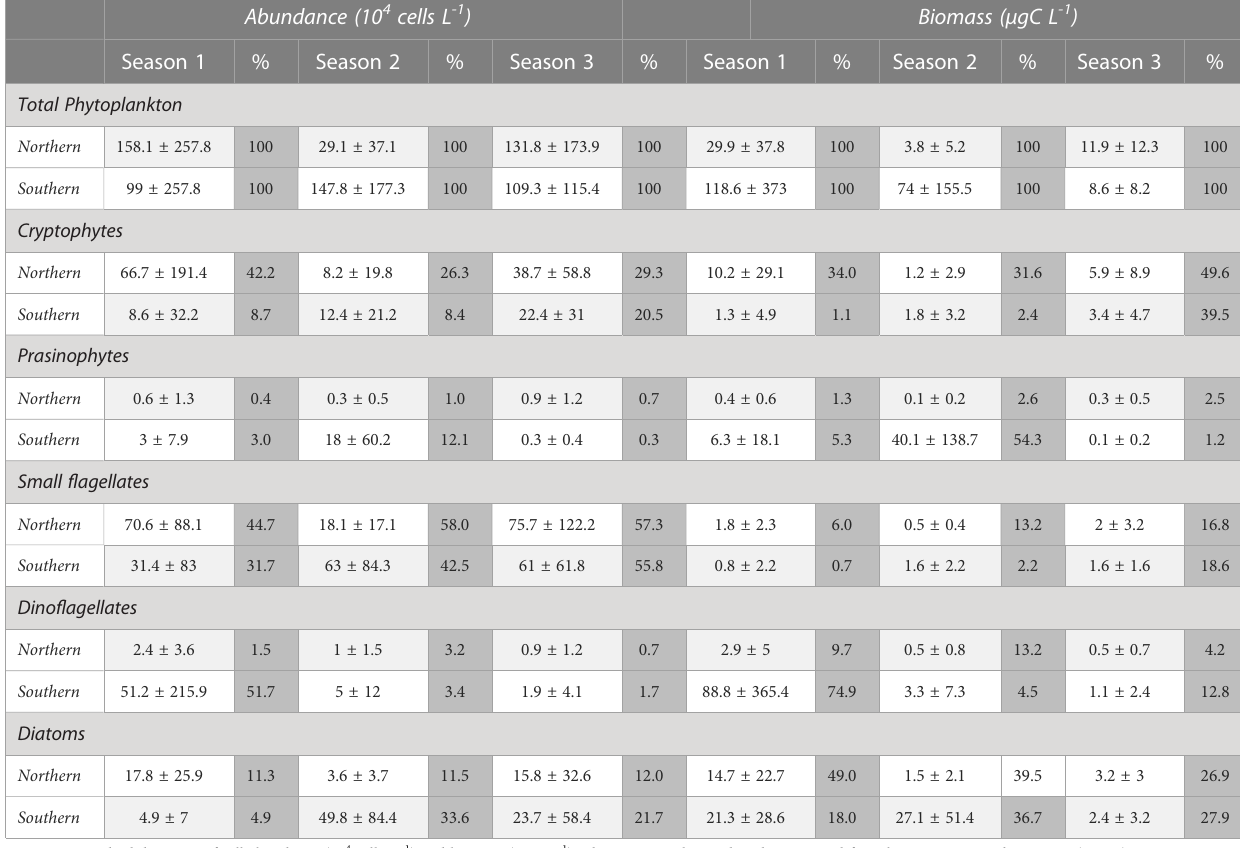
TABLE 1 Abundance and biomass average values and relative percentages of major phytoplankton groups during three consecutive summer